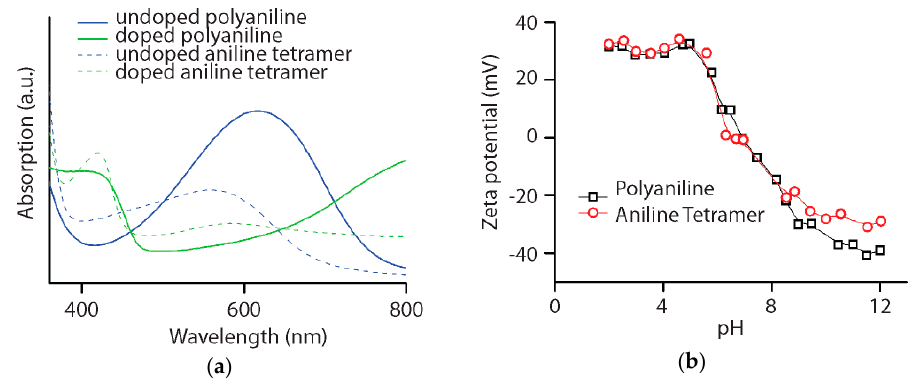
Figure 2. ( a ) UV–visible spectra of polyaniline and aniline tetramer demonstrating a color change from blue to green upon doping each in its emeraldine base state; ( b ) Zeta potential spectra of polyaniline and aniline tetramer exhibiting similar characteristics as a function of pH.